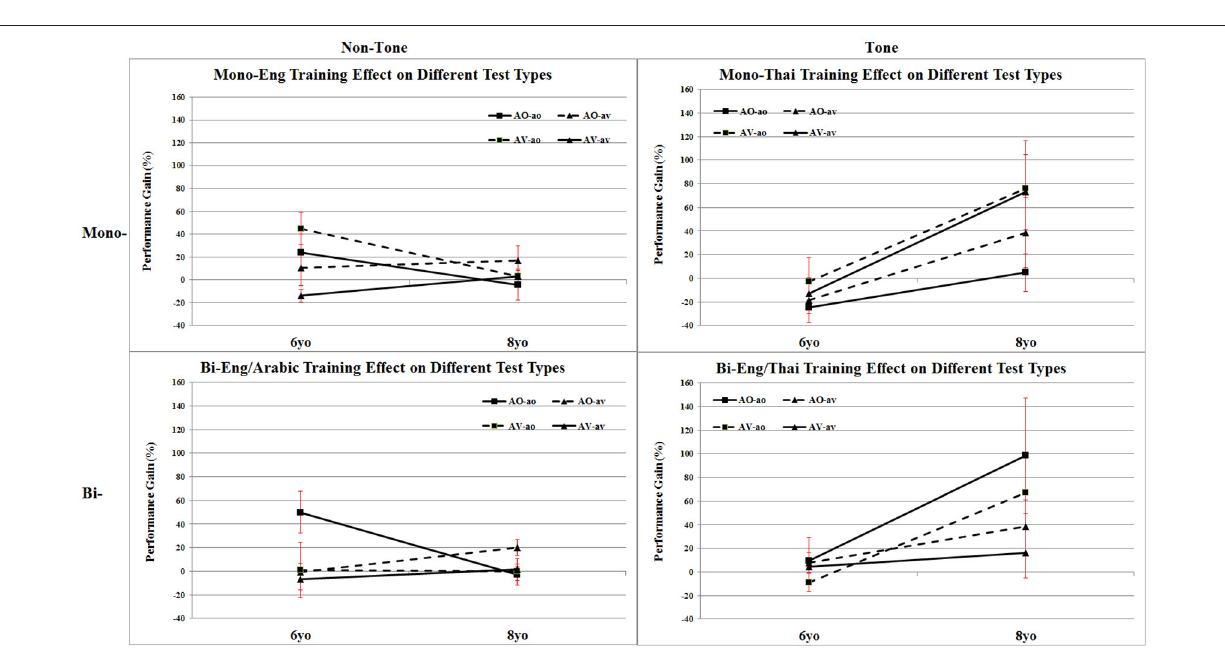
especially the case when indexed by ao test